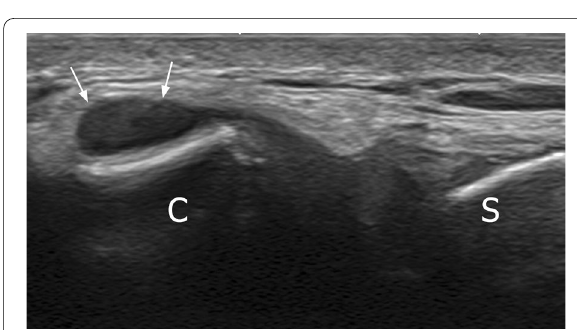
Fig. 6 Joint effusion seen as a bulging synovial recess in front of the clavicular end (upward and outward oblique transverse plane). C: clavicle, S: